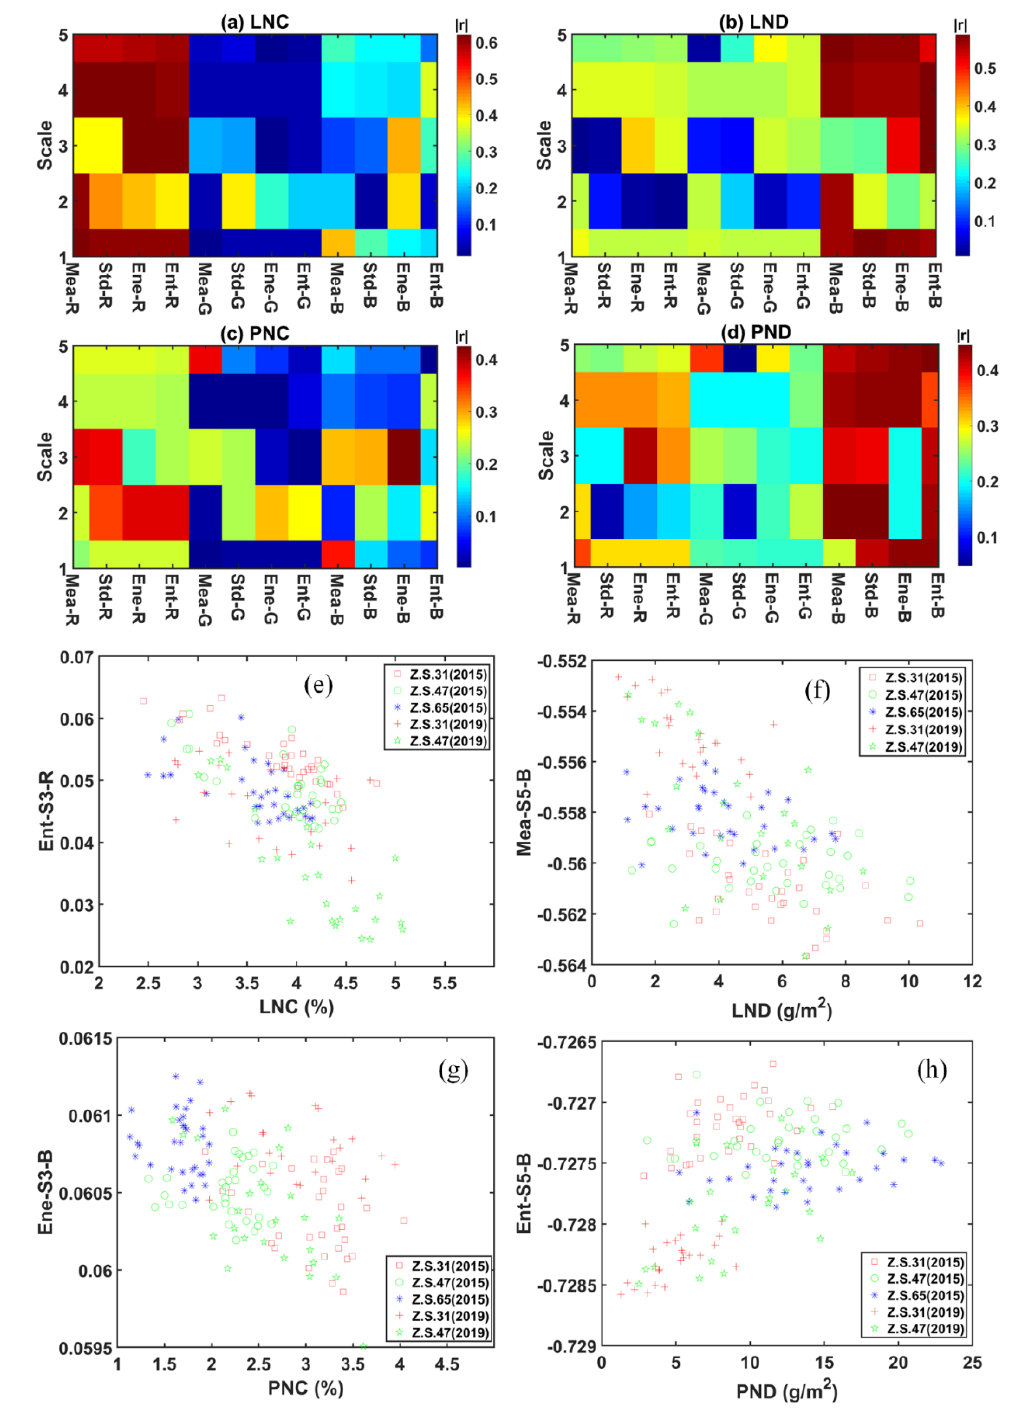
Figure 9. The responses of different Gabor-based textures to the four wheat N status indicators (i.e., LNC, PNC, LND, and PND) in the calibration dataset. ( a ) Pearson correlation analyses of Gabor-based textures and N status indicators, and ( b – h ) scatter plots of the best performing Gabor-based textures and N status indicators for each growth stage.